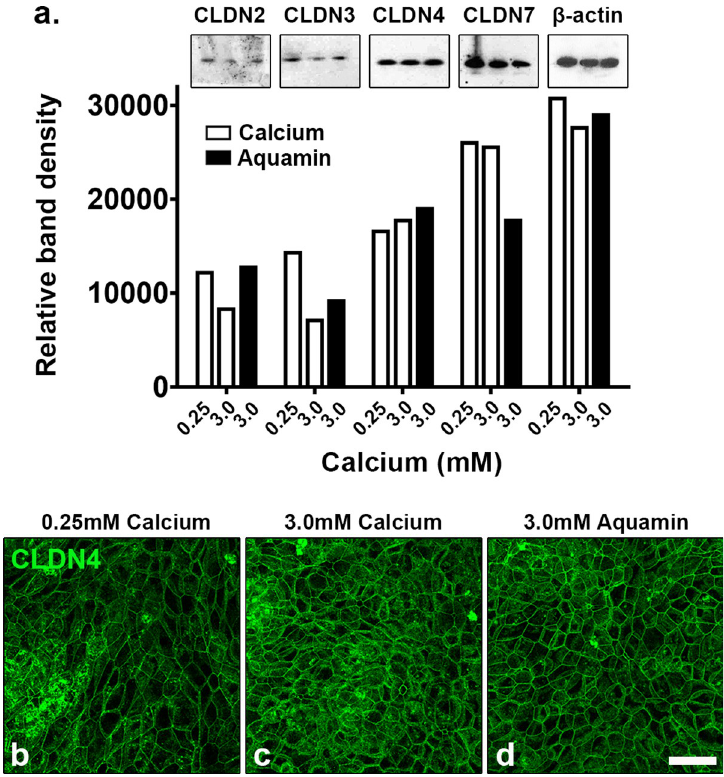
Fig 3. Evaluation of claudin expression by western blotting and confocal fluorescence microscopy. Colonoids were plated on transwell membranes and incubated under the indicated conditions. After TEER assessment at day-5, lysates from some membranes were prepared for western blotting and additional membranes were prepared for confocal fluorescence microscopy. a : Western blot: 10 μ g of protein from each condition was used. β -actin was used as a loading control. Band quantitation was done using ImageJ software. b-d : Claudin-4 (max projected) was assessed by confocal fluorescence microscopy. Scale bar = 10 μ m. CLDN = claudin.